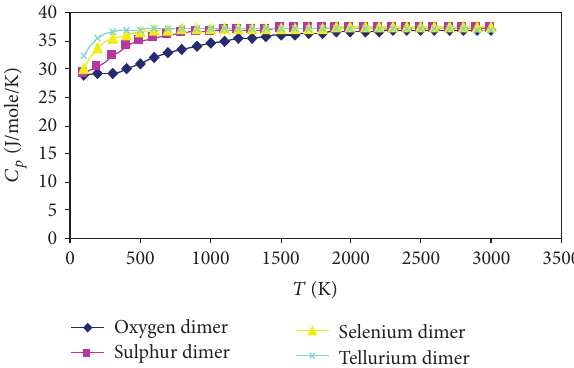
F 2: Variation of enthalpy ( H ) with temperature ( T ).